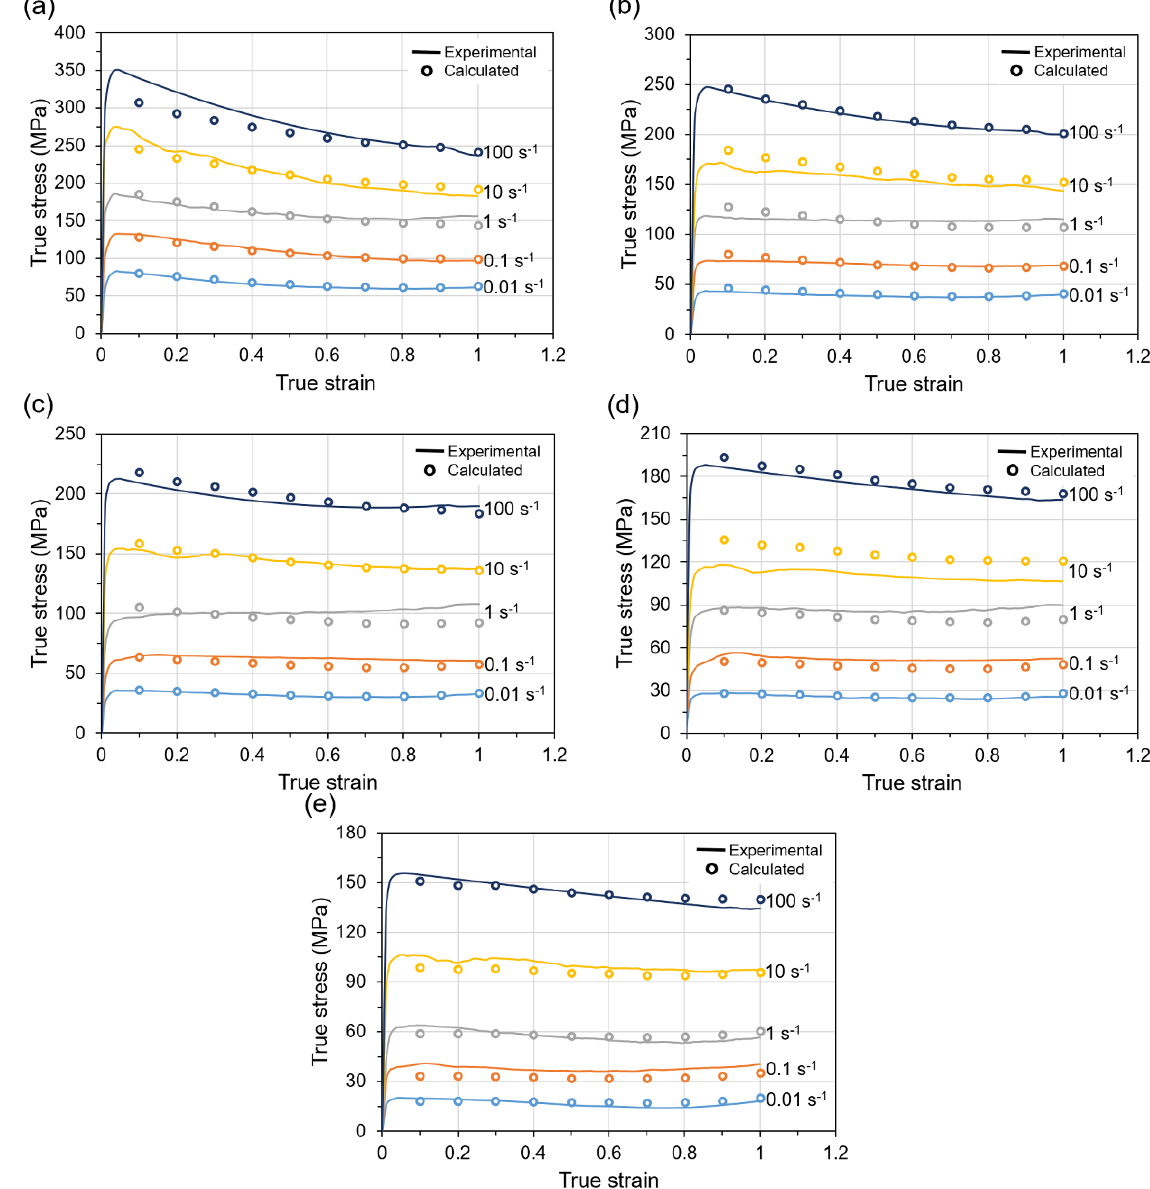
Figure 6. Experimental and calculated flow stresses for Ti-1023 alloy for deformation temperatures of ( a ) 800 °C, ( b ) 900 °C, ( c ) 950 °C, ( d ) 1000 °C, ( e ) 1100 °C.